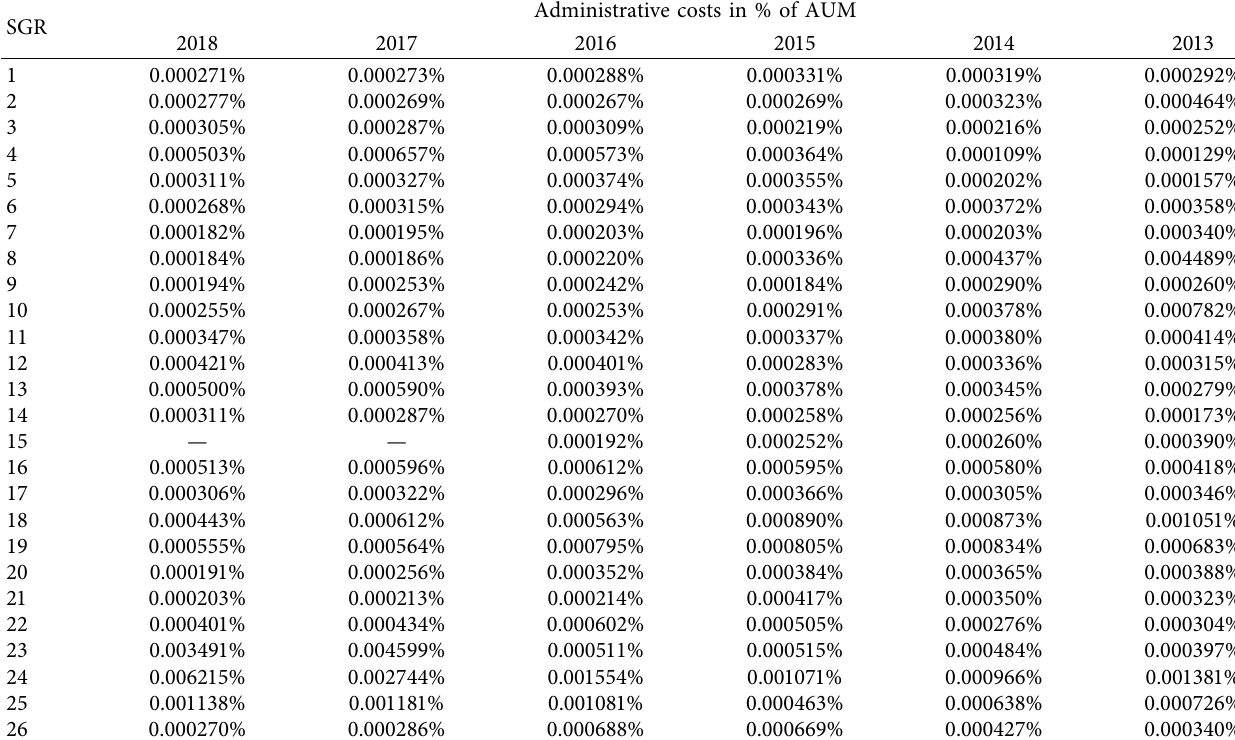
Table 6: Percentage of administrative costs in terms of AUM.